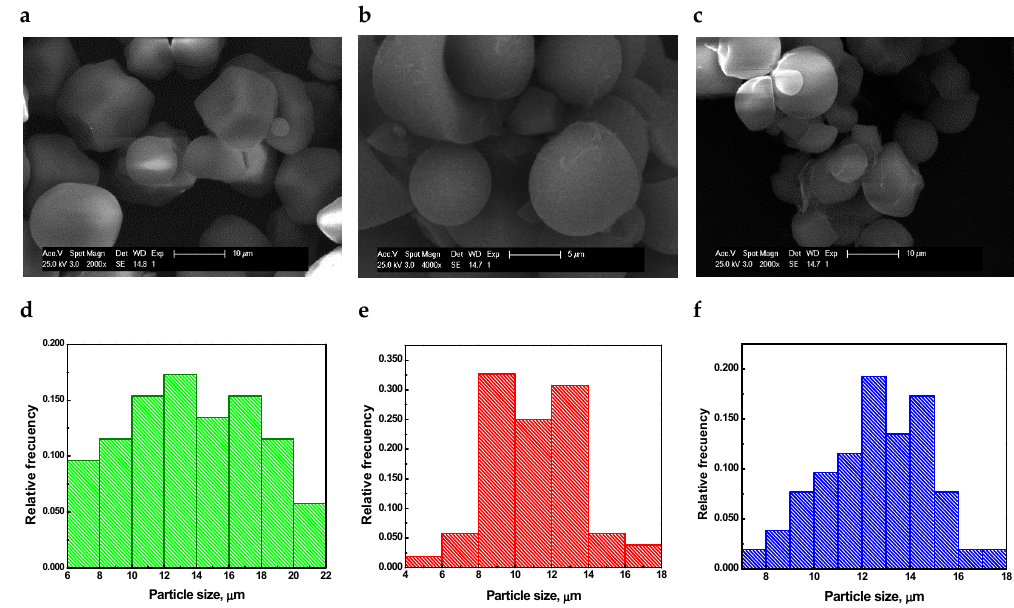
Figure 4. SEM images and the particle size distributions of ( a , d ) NCS, ( b , e ) NMES, and ( c , f ) NMUS, respectively.